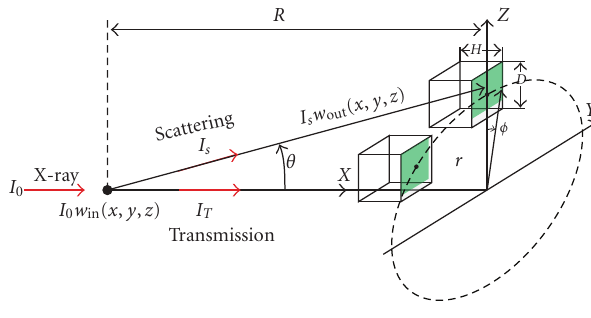
Figure 2: Geometry for detection of X-ray scattering signals.